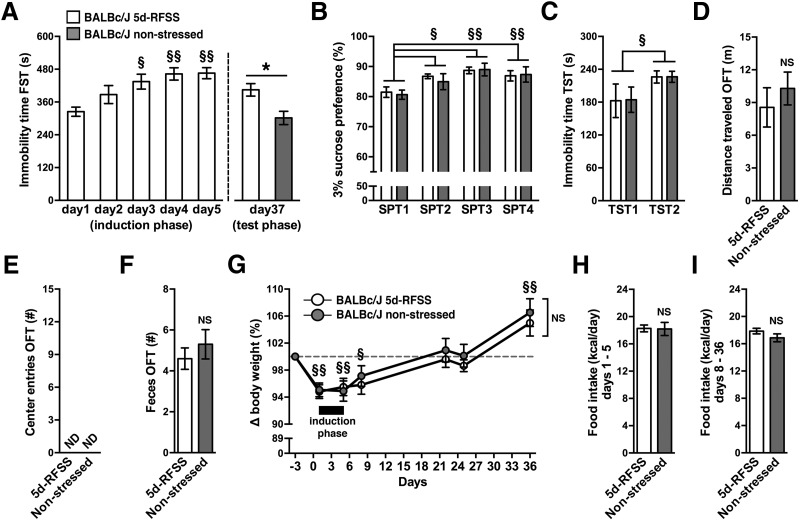
Effects of 5d-RFSS on depressive-like behavior in BALB/cJ mice. A, Immobility time of 5d-RFSS BALB/cJ mice during the induction phase (days 1–5) of forced swim tests (FST; main effect of time, F(4,36) = 6.29, p = 0.0006; post hoc test, §p = 0.02, §§p = 0.002 vs day 1) and of 5d-RFSS and nonstressed control mice during the test phase (day 37; t(1,18) = 3.08, *p = 0.007). B, Two-bottle SPTs before 5d-RFSS (SPT1) and after 5d-RFSS (SPT2 to SPT4; main effect of time, F(3,54) = 12.67, p < 0.00001; post hoc test, §p = 0.002, §§p = 0.0002 vs SPT1). C, TST immobility time before 5d-RFSS (TST1) and after 5d-RFSS (TST2; main effect of time, F(1,18) = 5.06, p = 0.04; post hoc test, §p = 0.04 vs TST1). D–F, Distance traveled (t(1,18) = 0.74, p = 0.47; D), number of center zone entries (E), and number of feces produced during the OFT (t(1,18) = 0.79, p = 0.44; F). G, Change in body weight (%) from days −3 to 36 (main effect of time, F(6,108) = 36.96, p < 0.00001; post hoc test, §p = 0.002, §§p = 0.0001 vs day −3). H, I, Food intake during the induction phase (days 1 – 5; t(1,18) = 0.07, p = 0.94; H) and during days 8–36 (t(1,18) = 1.36, p = 0.19; I). NS, Not significant; ND, not detected. n = 10/group for all experiments.